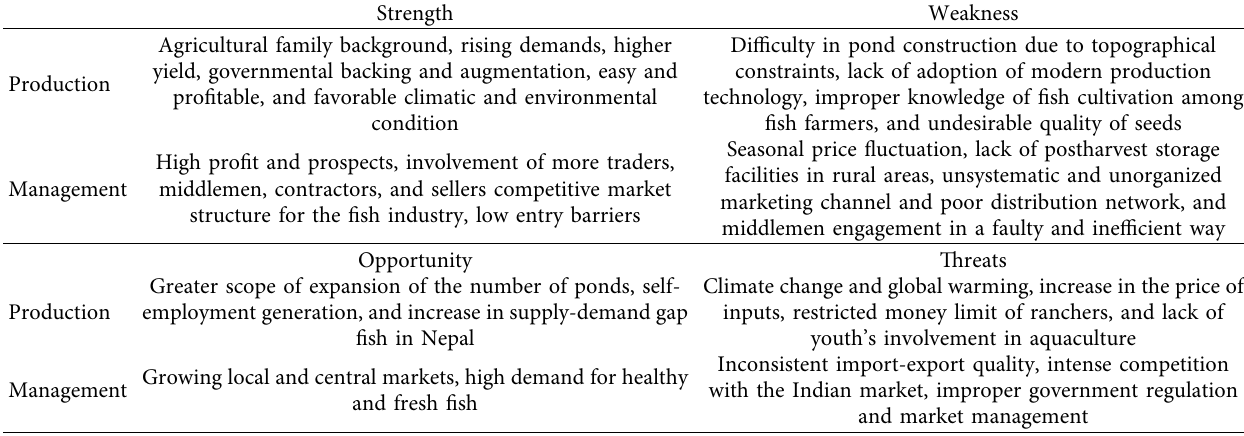
Figure 10: Major problems faced by fish farmers in Nepal. Table 13: SWOT analysis of production and marketing of fish in